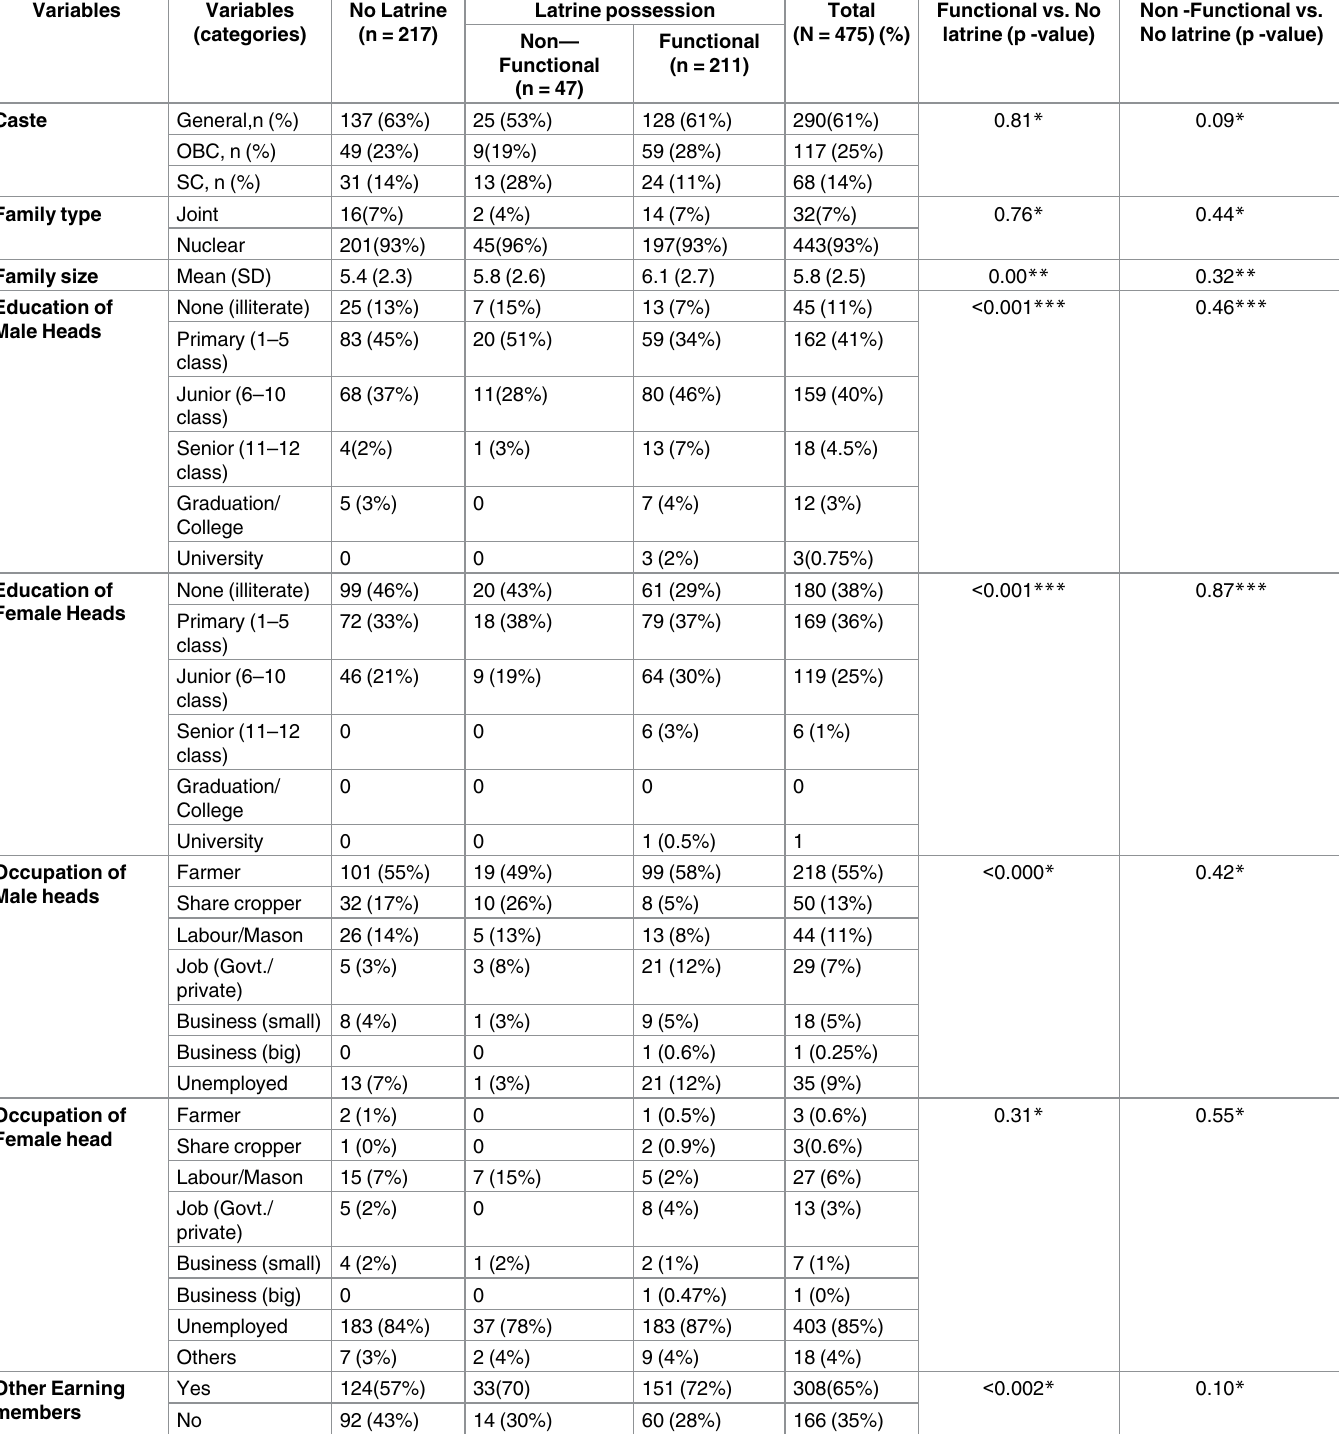
Table 2. Characteristics of respondents (n =